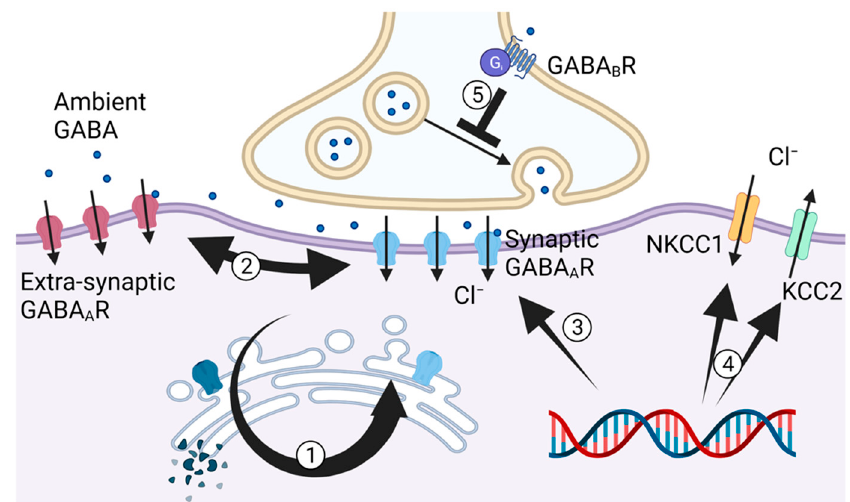
Figure 2. Regulatory mechanisms of GABAergic receptors, sodium potassium chloride co-transporter NKCC1, and potassium chloride co-transporter KCC2. Intracellular trafficking of GABA A R involves internalization into the Golgi, lysosomal degradation, or recycling through the endoplasmic reticulum and membrane re-insertion (1). Lateral mobilization of GABA A R between synaptic and extrasynaptic domains (2) and transcriptional regulation of GABA A R (3). Transcriptional regulation of NKCC1 and KCC2 (4). Presynaptic GABA B R regulating presynaptic neurotransmitter release (5).